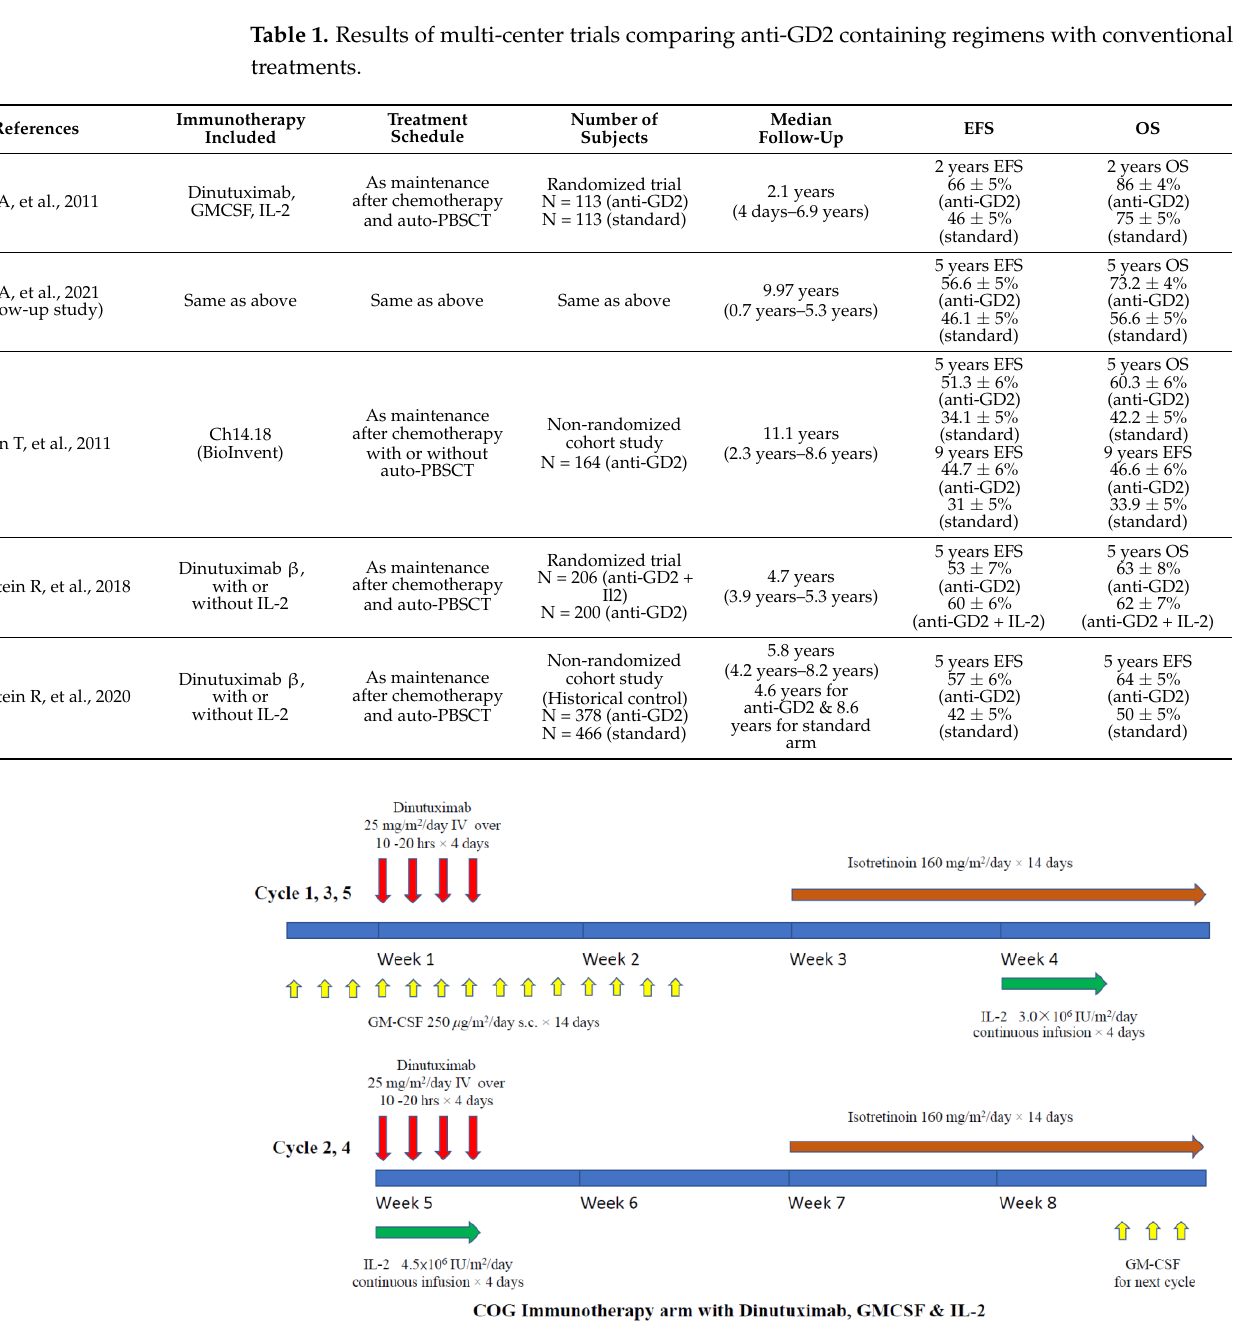
Figure 3. Treatment schema of COG maintenance immunotherapy (dinutuximab) with GM-CSF and IL-2. and